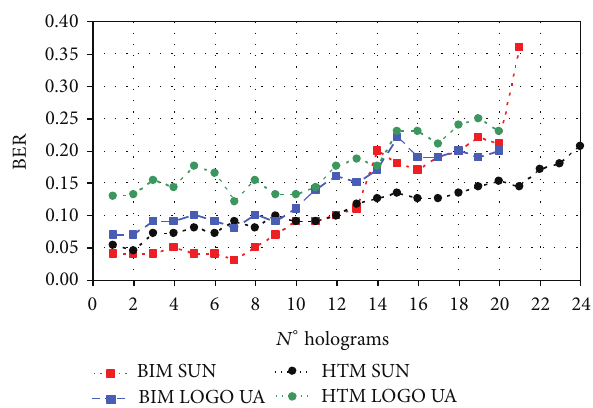
Figure 5: BER values obtained multiplexing the object of SUN and LOGO UA for the BIM and HTM.